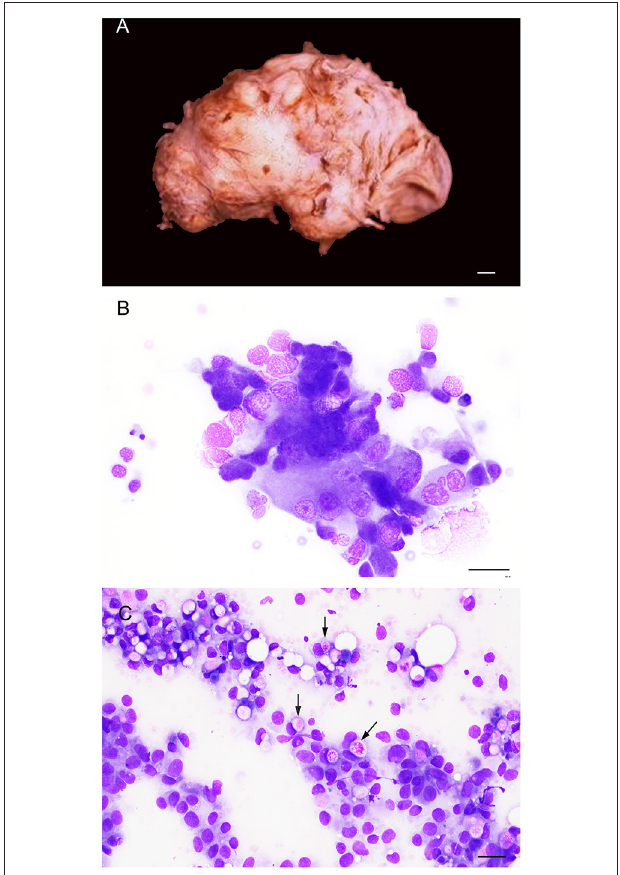
FIGURE 11 | Gross (A) and cytological (B,C) features of prostatic carcinoma in dogs. (A) The prostate is irregularly enlarged, showing a multinodular gross aspect (entire prostate removed from the connections with the urinary bladder and penile urethra). Bar = 1cm. (B) Prostate aspirate showing a small group of neoplastic cells with cytological features of malignancy (pleomorphism, large nuclei, multiple prominent nucleoli). Prostate FNA, smear. Wright-Giemsa stain. Bar = 25 µ m. (C) Prostate aspirate showing neoplastic epithelial cells from a urothelial carcinoma of the prostate with intracytoplasmic vacuoles containing bright pink material (arrows). Prostate FNA, smear. Wright-Giemsa stain. Bar = 20 µ